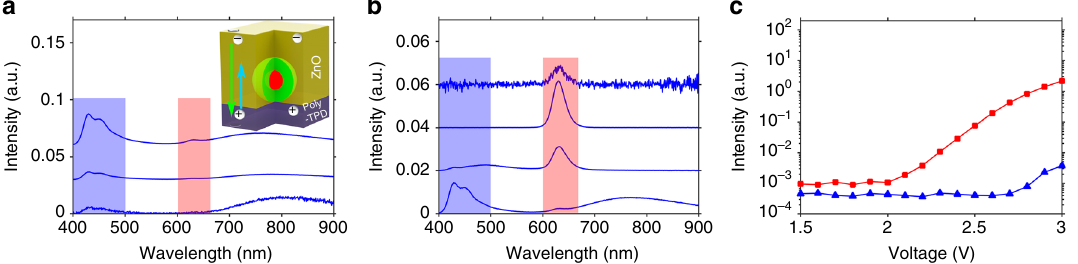
Fig. 2 Optimization of the isolating fi lm thickness. a Electroluminescence spectra of a device inheriting the conventional LED structure, i.e., isolated quantum dots directly sandwiched between the Poly-TPD and ZnO (without the PMMA layer, see inset for schematic drawing), at 3.0 V, 2.5 V, and 2.0 V (from top to bottom). The intensity of electroluminescence spectrum at 2.0 V is magni fi ed by a factor of 20. b Electroluminescence spectra of the devices with isolated quantum dots embedded in PMMA layers with thicknesses of 17 nm, 12 nm, 10.4 nm and 0 nm, respectively (from top to bottom). The intensity of electroluminescence spectrum of device with a PMMA layer thickness of 17 nm is magni fi ed by a factor of 50. The spectra are taken at a bias of 2.8 V. c Voltage-dependent integrated electroluminescence intensity from the isolated quantum dots (red squares) and Poly-TPD (blue triangles) in a device with a 12-nm PMMA layer. For quantitative comparison, all spectra were acquired from a 1-mm 2 emitting area of the devices. Red shaded areas (600 – 660 nm) and blue shaded areas (400 – 500 nm) in a and b illustrate the integration ranges used for quantum dot and Poly-TPD electroluminescence intensity calculations shown in ( c